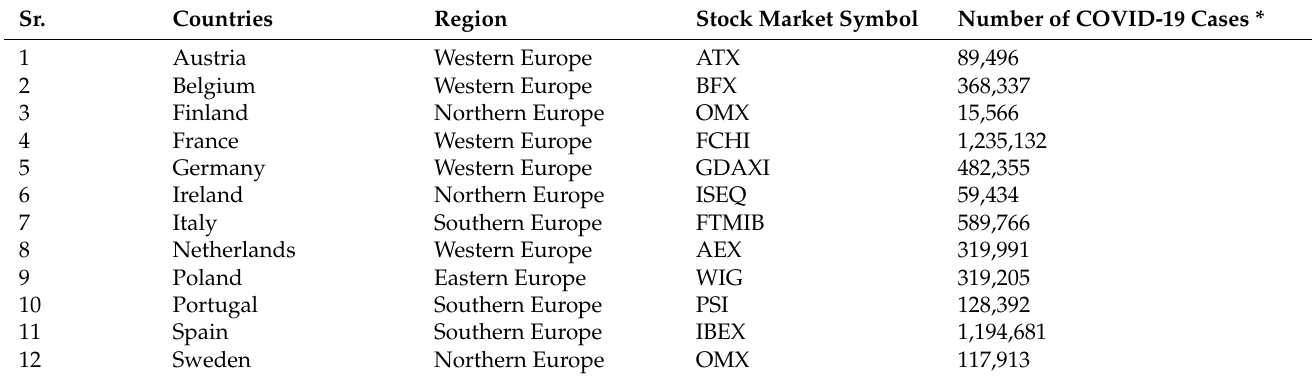
Table 1. Country Specific